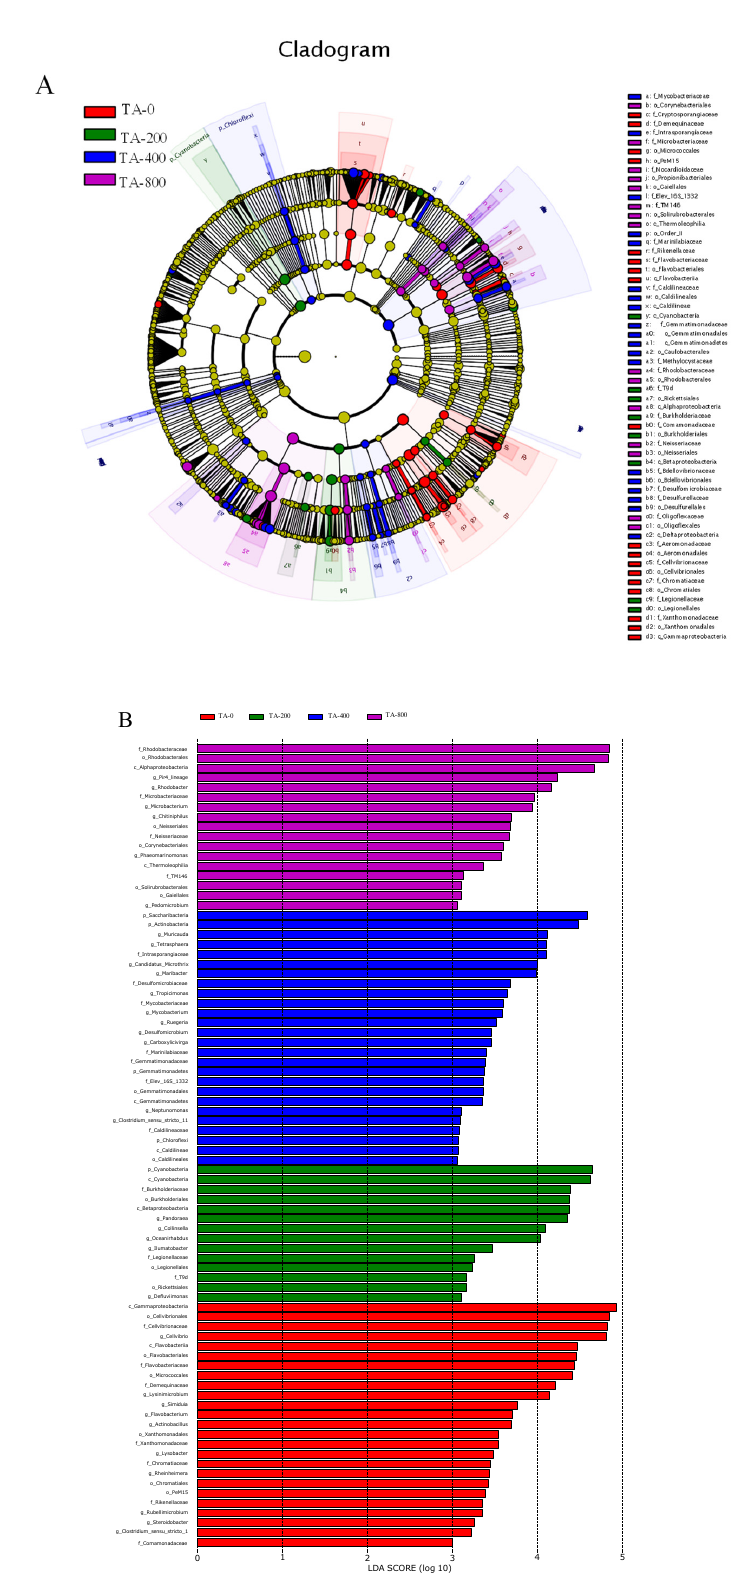
Figure 9. Intergroup variation analyses of the intestinal microbes of L. vannamei in different treatments. ( A ) LEfSe cladogram. ( B ) LDA score of